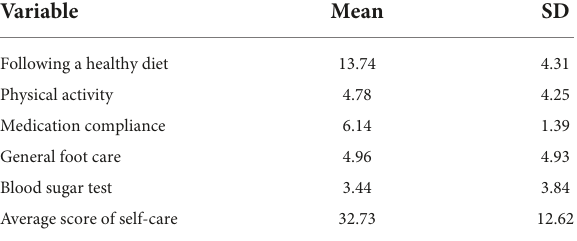
TABLE 1 Mean and standard deviation of self-care scores and its dimensions.